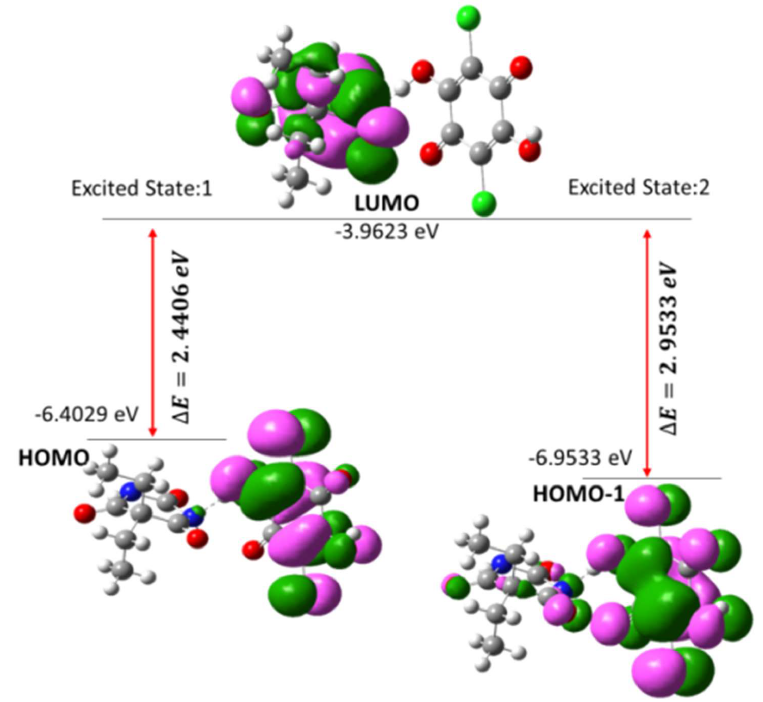
Figure 12. HOMO, HOMO-1 and LUMO plot. Numbers represent energy gaps. The HOMO to LUMO and HOMO-1 to LUMO gaps (∆E) for (Bar–CLA) were ob- served to be 2.4406 and 2.9533 eV, respectively (Figure 12) [58]. Table S6 lists a few gas- phase molecular parameters according to HOMO–LUMO plot.